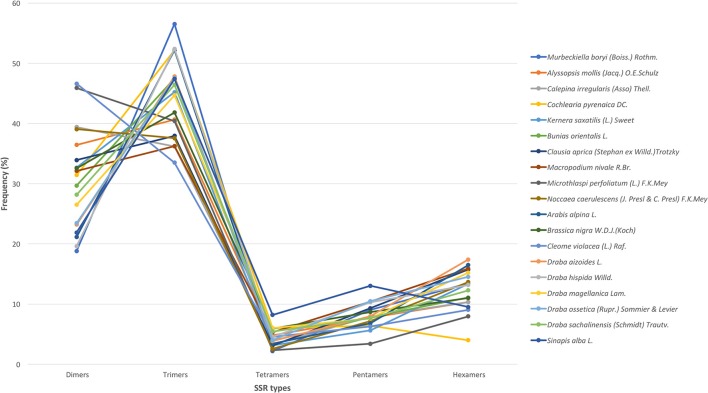
SSR's types distribution across species. In the x-axis, each type of motif is indicated while the y-axis refers to the percentage of each type of motif in each species. Each species is denoted by a color as shown in the legend.